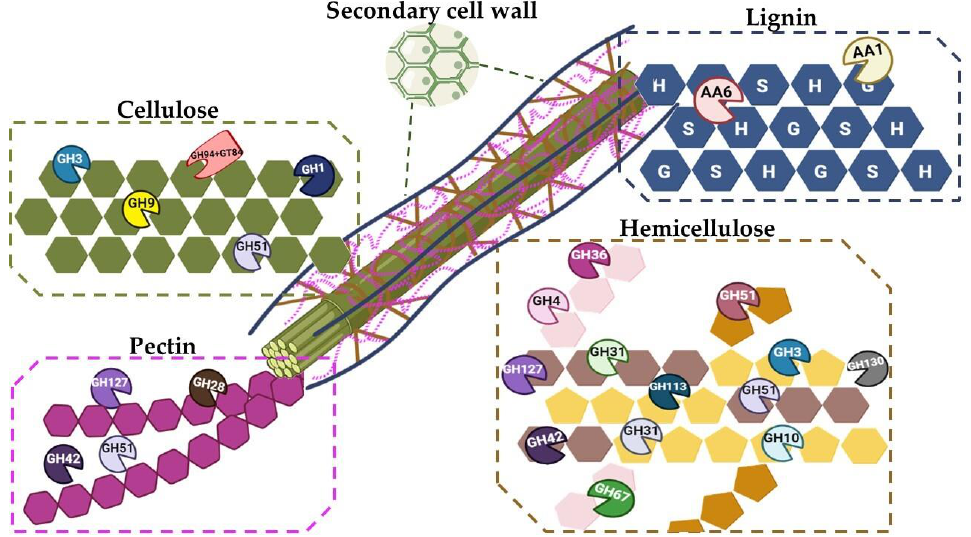
Figure 1. Overview of A. mali FL18 GHs on different lignocellulose components. All the GHs revealed by functional annotation are indicated as acting on their preferential lignocellulose substrate.